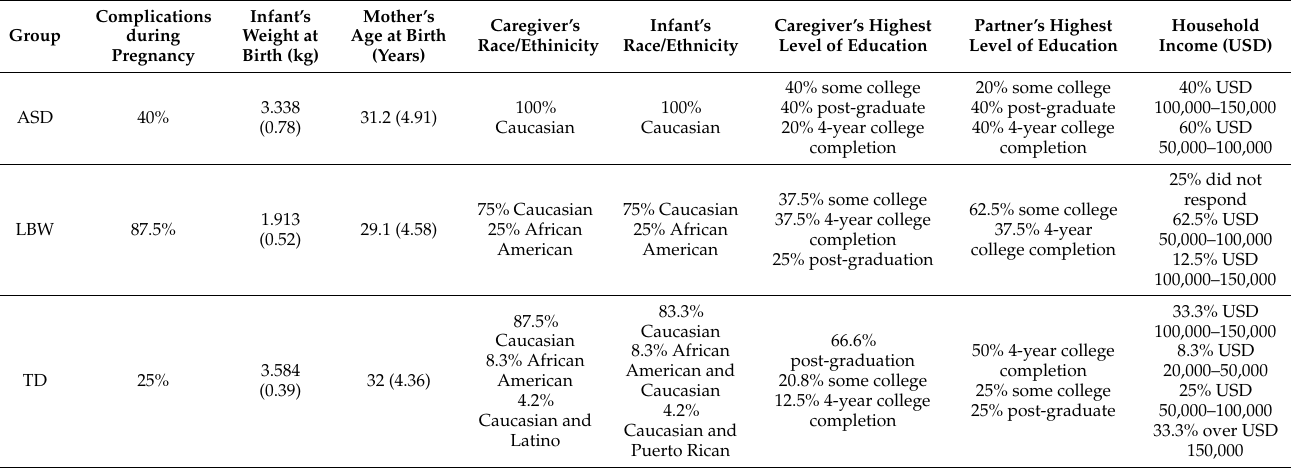
Table 1. Participant demographics. Caregivers for all infant participants were parents.